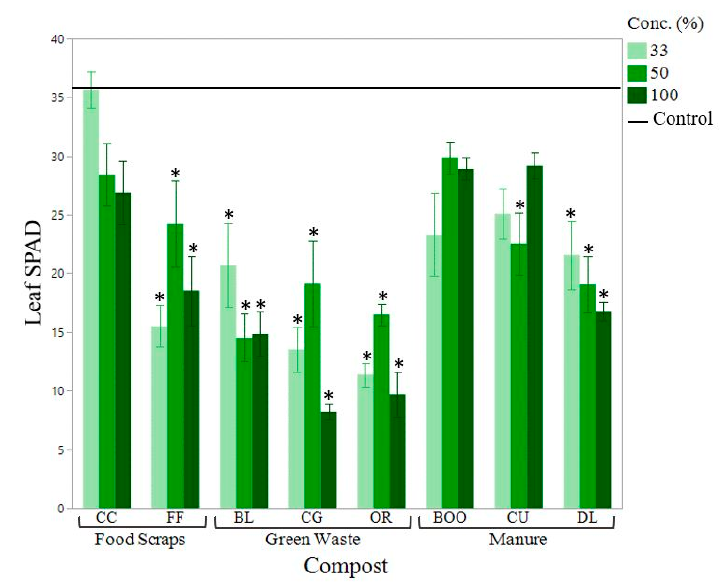
Figure 5. Mean bean leaf SPAD (greenness) by compost type. SPAD was taken using the second round of growth on bean plants. The mean of four separate measurements with the SPAD-meter was calculated for each plant. Compost concentration of the growing media shown from dark to light (100%, 50%, 33% compost). Horizontal solid black line indicates the mean shoot weight of the control (soil). Error bars denote standard error (n = 6). Stars (*) indicate significant from the control ( α = 0.05).